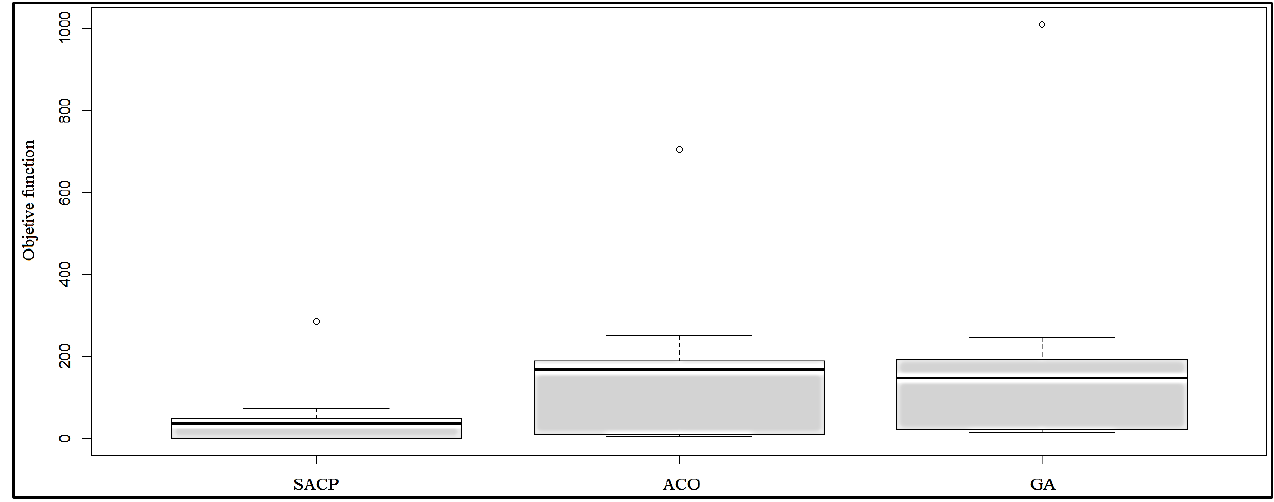
Figure 12. Boxplot of the SACP, ACO and GA